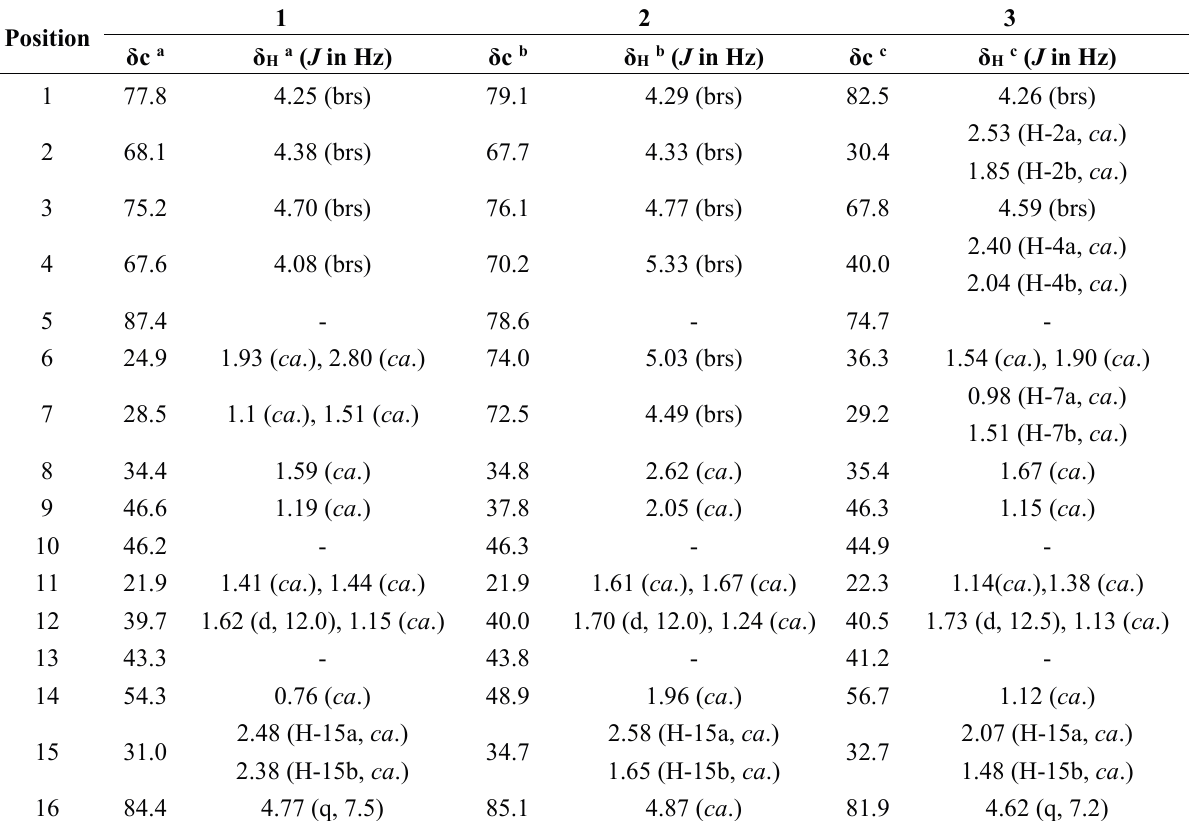
Table 1. 1 H-NMR and 13 C-NMR spectral data of compounds 1 – 3